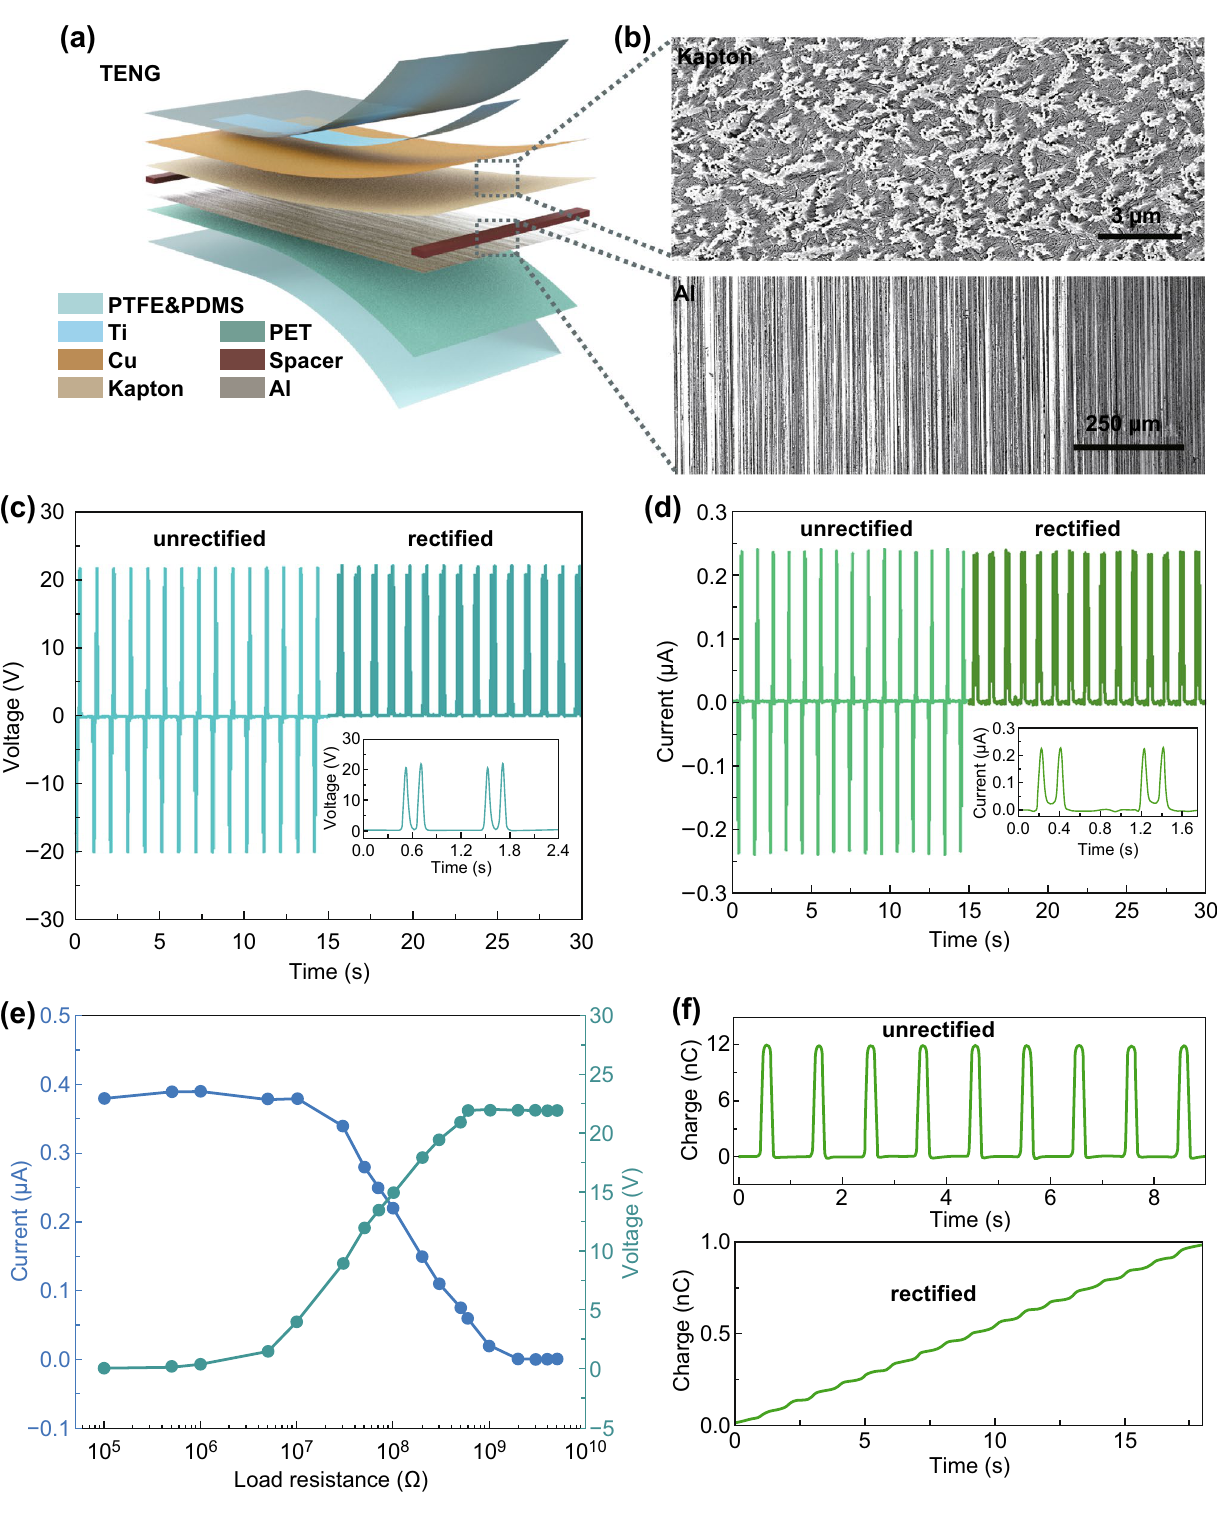
Fig. 2 a Structure diagram of TENG. b Surface micromorphology of Kapton film and Al foil. c Working mechanism of TENG with a contact‑ separation mode. d Output voltage and e output current of TENG before and after rectification. f Transferred charge of TENG before (upper) and after (lower)